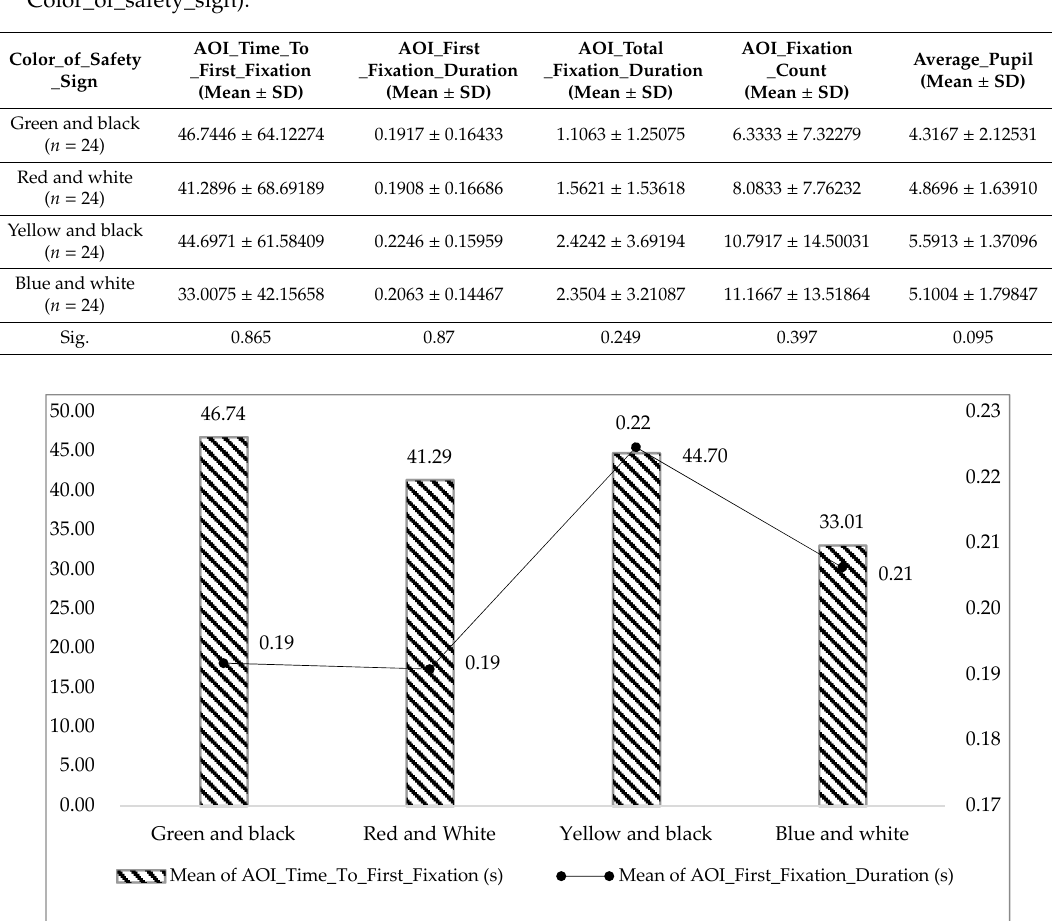
Figure 8. Mean of AOI_Time_To_First_Fixation and mean of AOI_First_Fixation_Duration in the four color